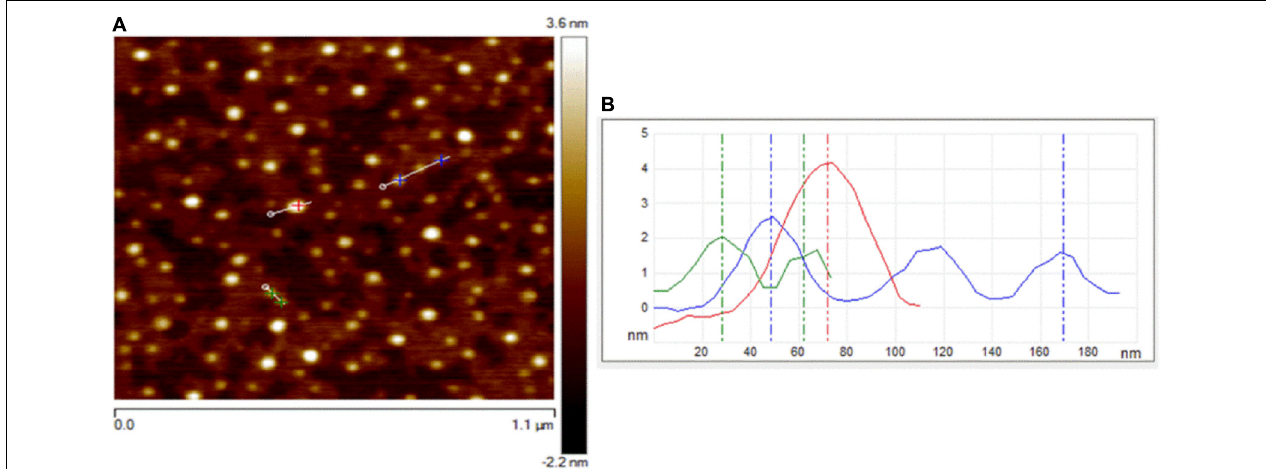
FIGURE 1 | AFM images of C-DOTS. (A) AFM image of C-DOTS deposited on a mica substrate. (B) The height profiles along the lines of the panel from C-DOTS.